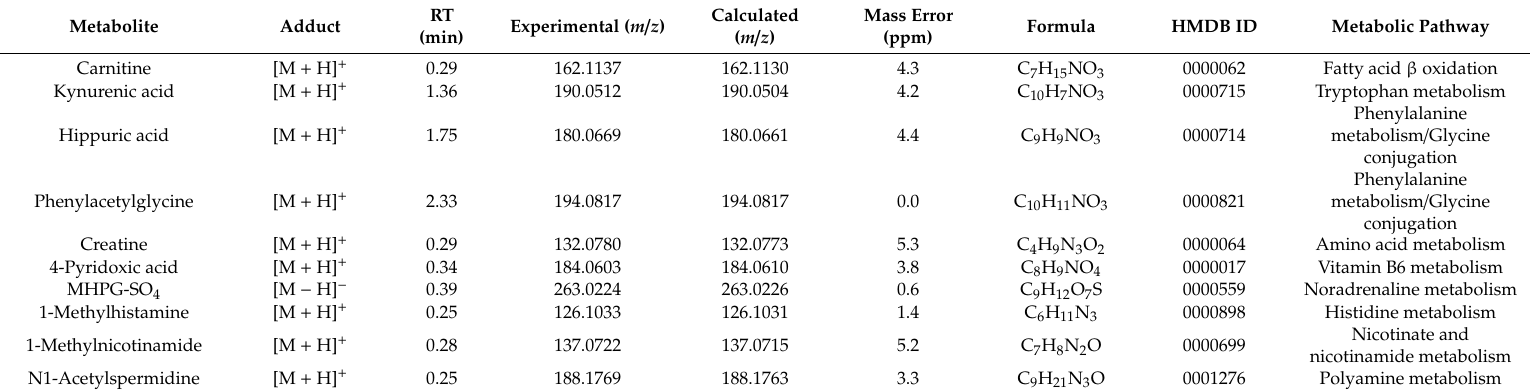
Table 1. Validated urinary metabolites at 4 and 24 h in wild-type and p53 − / − mice after ionizing radiation exposure.